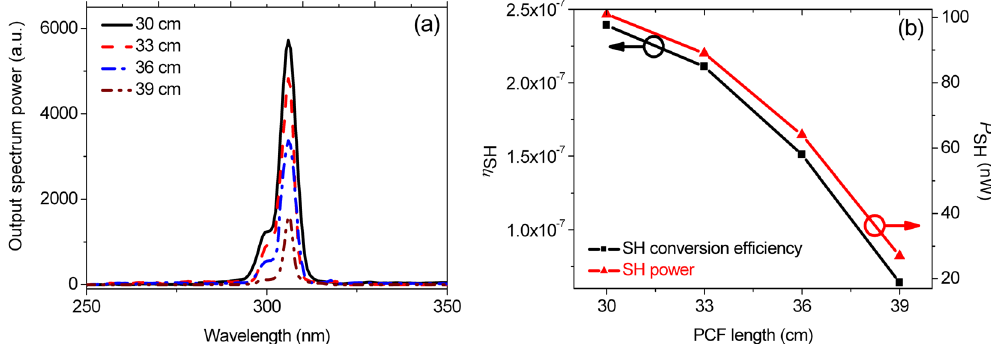
Figure 4. For femtosecond pump pulses with center wavelength λ p = 840 nm and average input power P av = 650 mW (peak power equals 78 kW), when the PCF length is changed from 30, to 33, to 36, and to 39 cm, respectively, ( a ) the observed output spectra of the SHs, and ( b ) the measured output power P SH and conversion efficiency η SH of the SHs as a function of the PCF length.